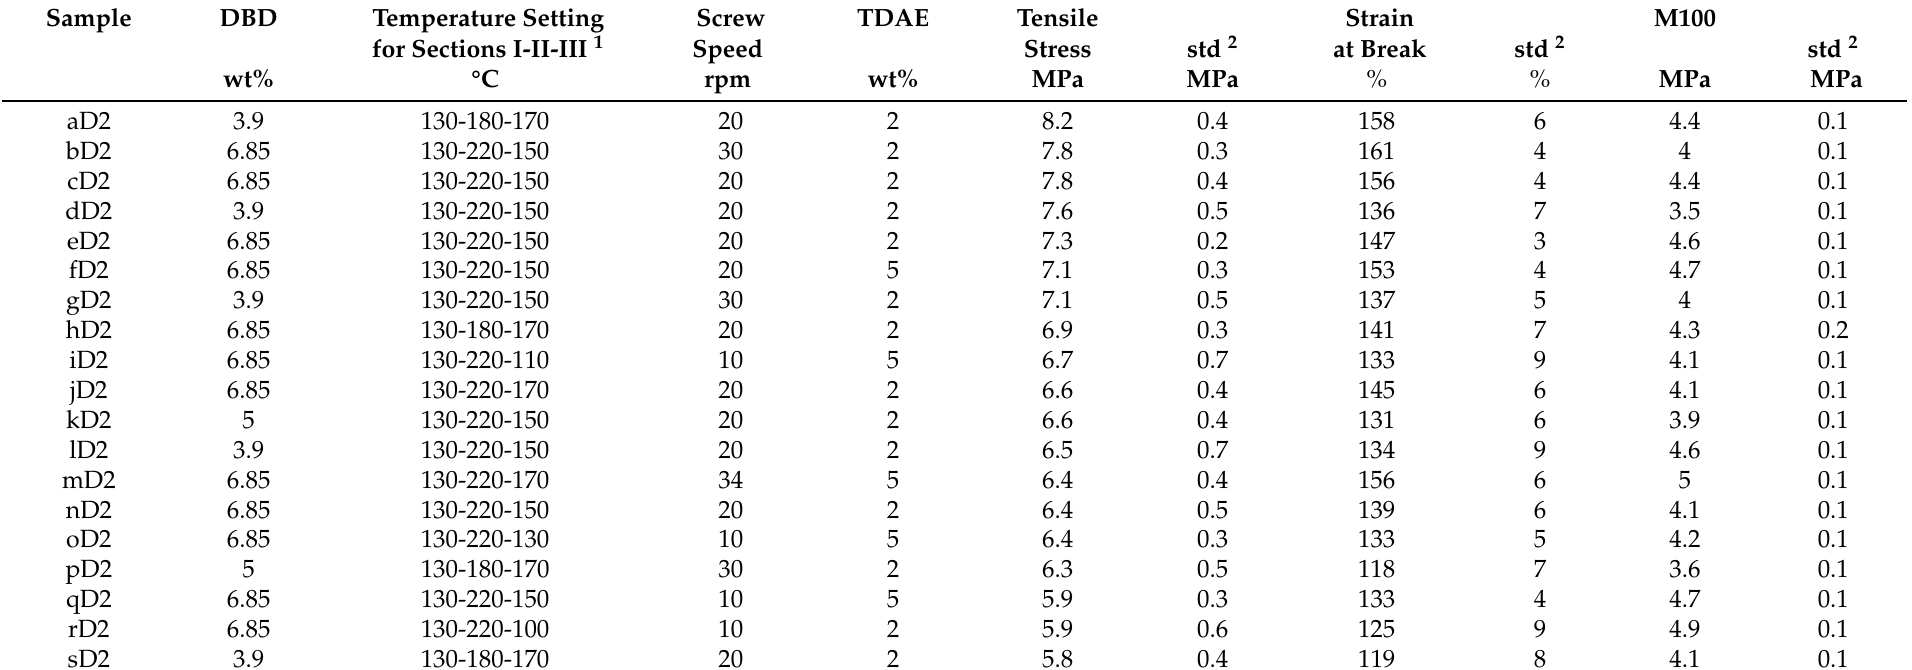
Table 5. Tensile values after re-vulcanization with a silica-silane based formulation. Values after de-vulcanization using screw D , revulcanized with formulation II , Table A3.